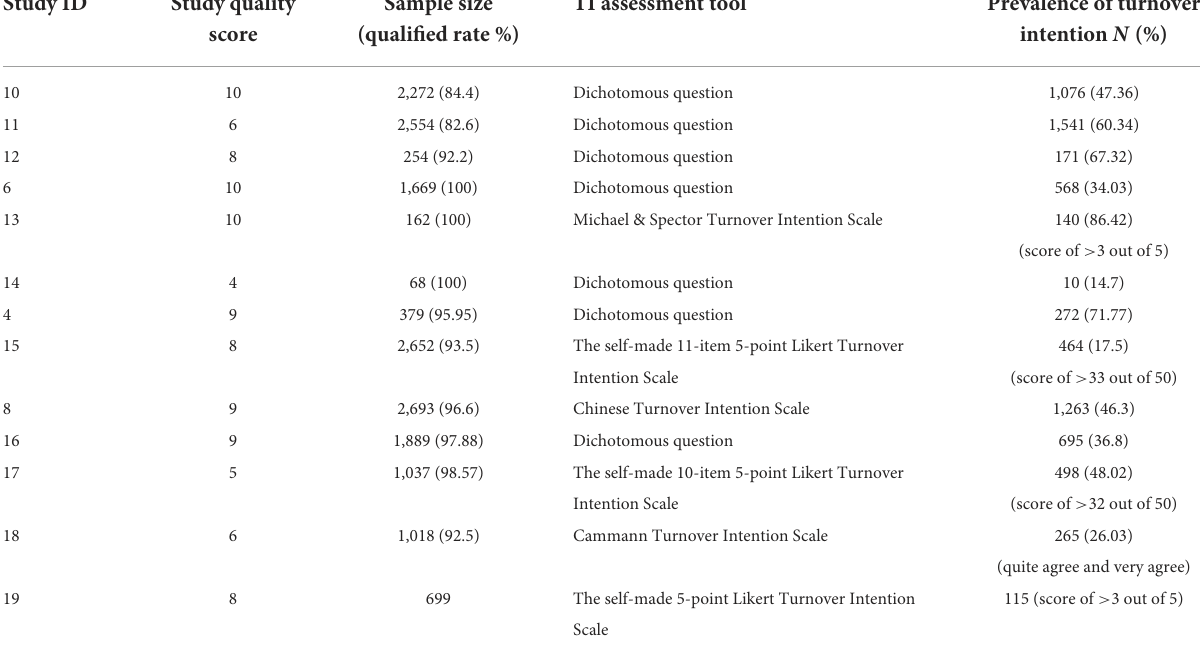
TABLE 2 A characteristic of 13 included studies of turnover intention among Chinese